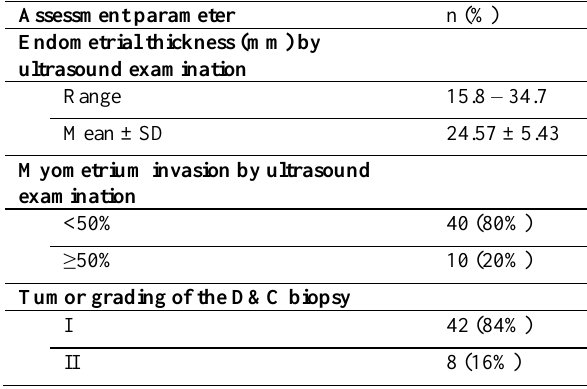
Table 2: Pre-operative tumor assessment Assessment parameter